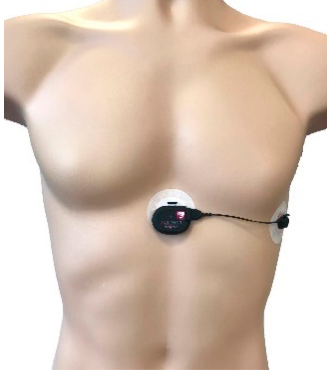
Figure 2. Actiheart 5 device (image used with permission from Actiheart [35]).